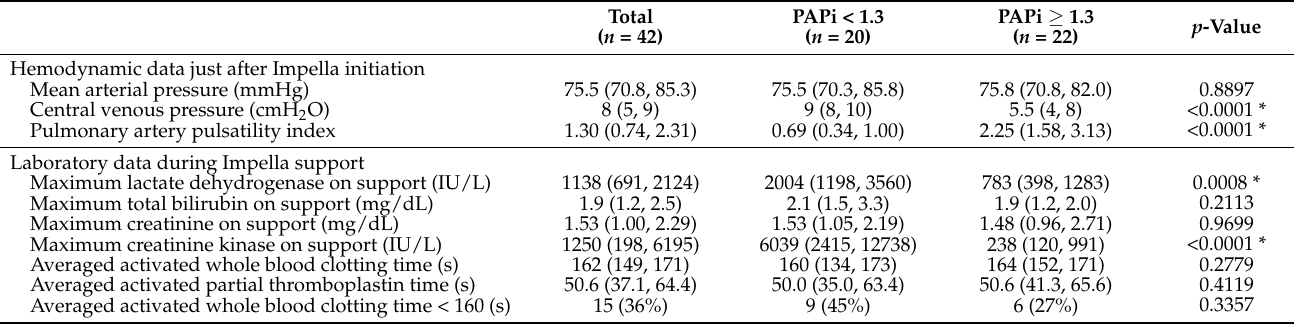
Table 3. Hemodynamic and laboratory data during Impella